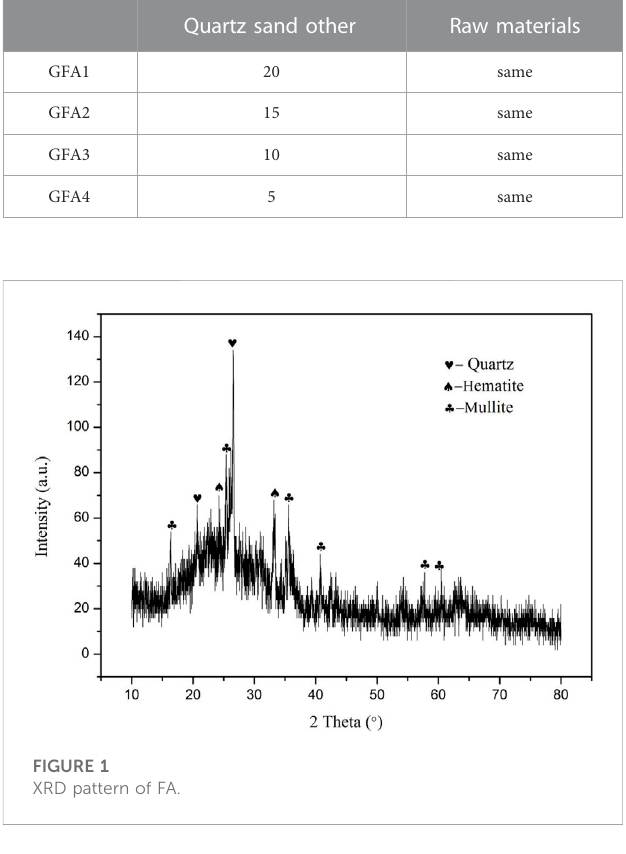
FIGURE 1 XRD pattern of